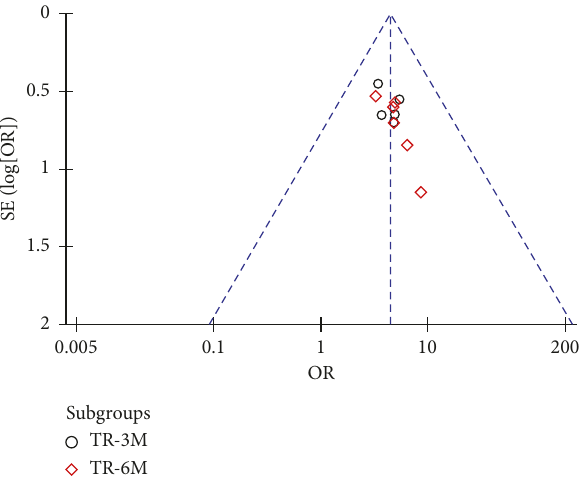
Figure 10: Funnel plots of TR published